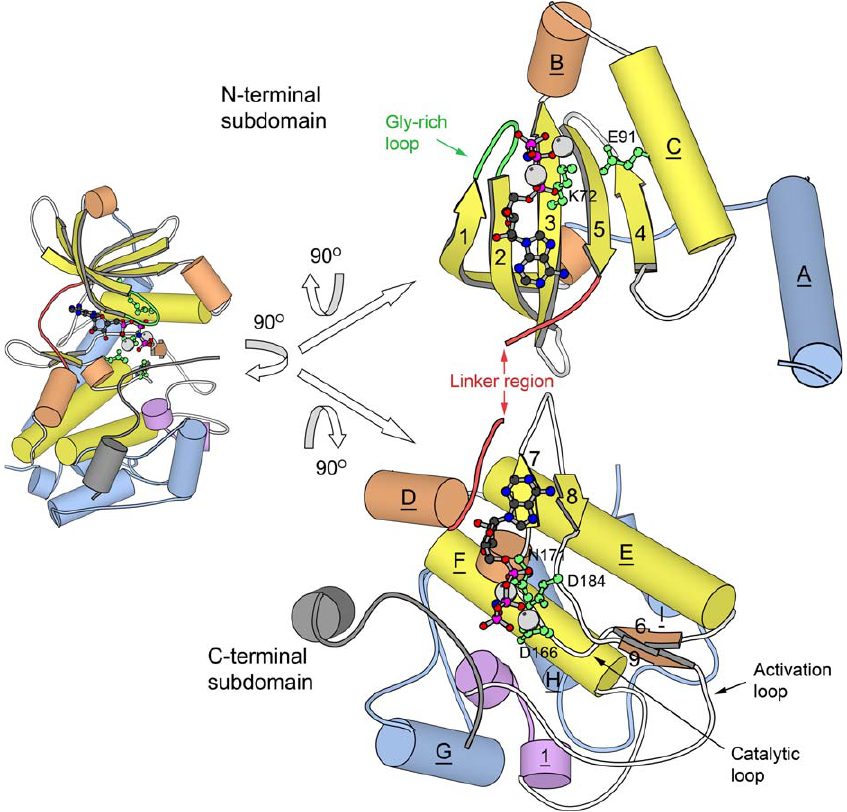
the figure. Molecular renderings in this figure were created with MOLSCRIPT [90]. DOI: 10.1371/journal.pcbi.0010049.g001